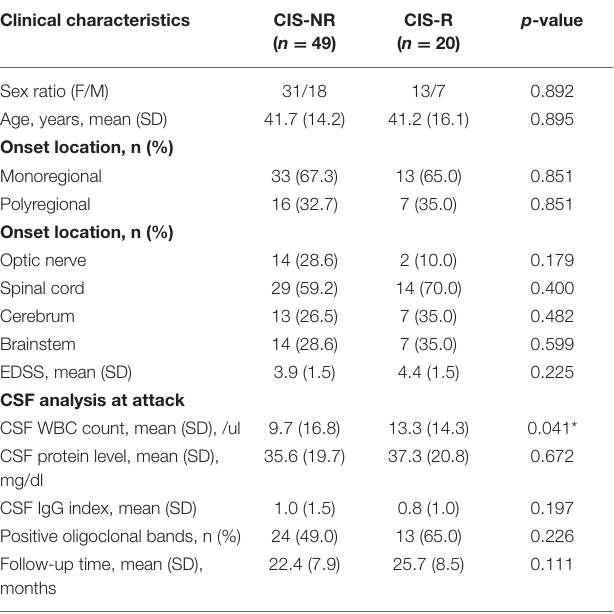
TABLE 1 | Characteristics of the patients with clinically isolated syndromes